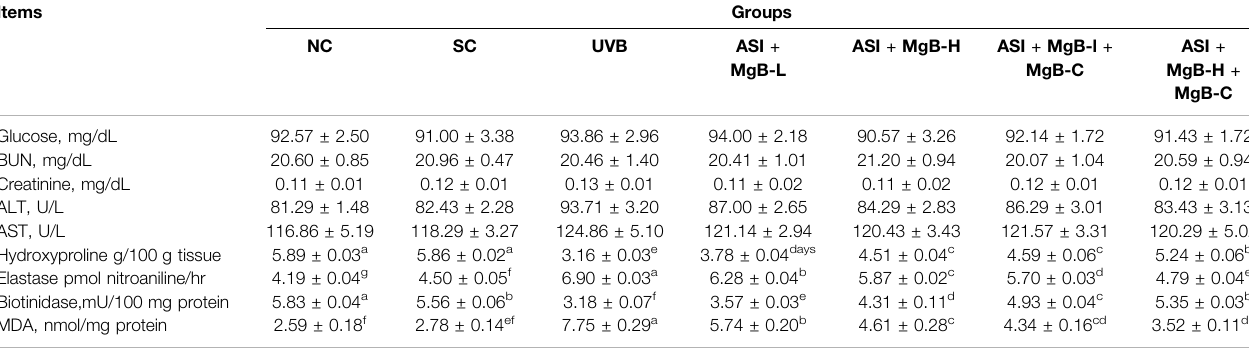
TABLE 1 | Effect of inositol-stabilized arginine silicate complex (ASI) and magnesium biotinate (MgB) on serum biochemical parameters, skin hydroxyproline, elastase, biotinidase and MDA levels in rats with UVB-induced photoaging. Items Groups